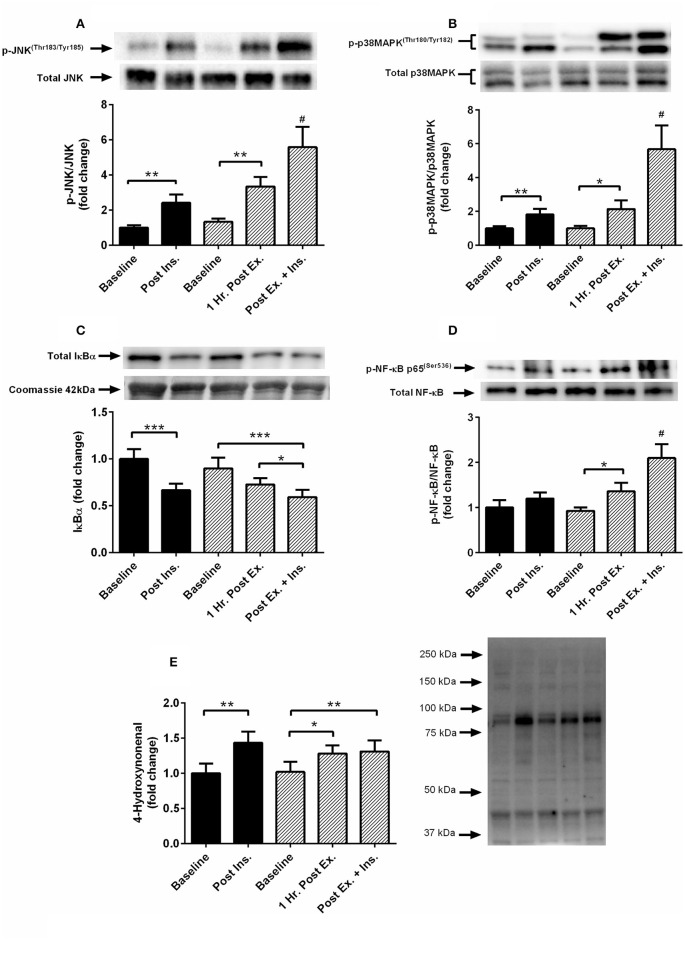
Exercise, insulin stimulation, and skeletal muscle SAPK signaling. Phosphorylation relative to total protein content in skeletal muscle 1 h after exercise (prior to insulin stimulation), and pre and post insulin stimulation at rest and 3 h after exercise (n = 11). (A) JNK(Thr183/Tyr185); (B) p38 MAPK(Thr180/Tyr182); (C) IκBα; (D) NF-κB p65(Ser536); (E): 4-hydroxynonenal. *p < 0.05, **p < 0.01, ***p < 0.001 and # is significantly different to all time-points in both the rest and exercise trial. Black bars = rest trial. Diagonal line bars = exercise trial. Ex. = High-intensity interval exercise. Ins. = insulin stimulation via the hyperinsulinaemic-euglycaemic clamp.